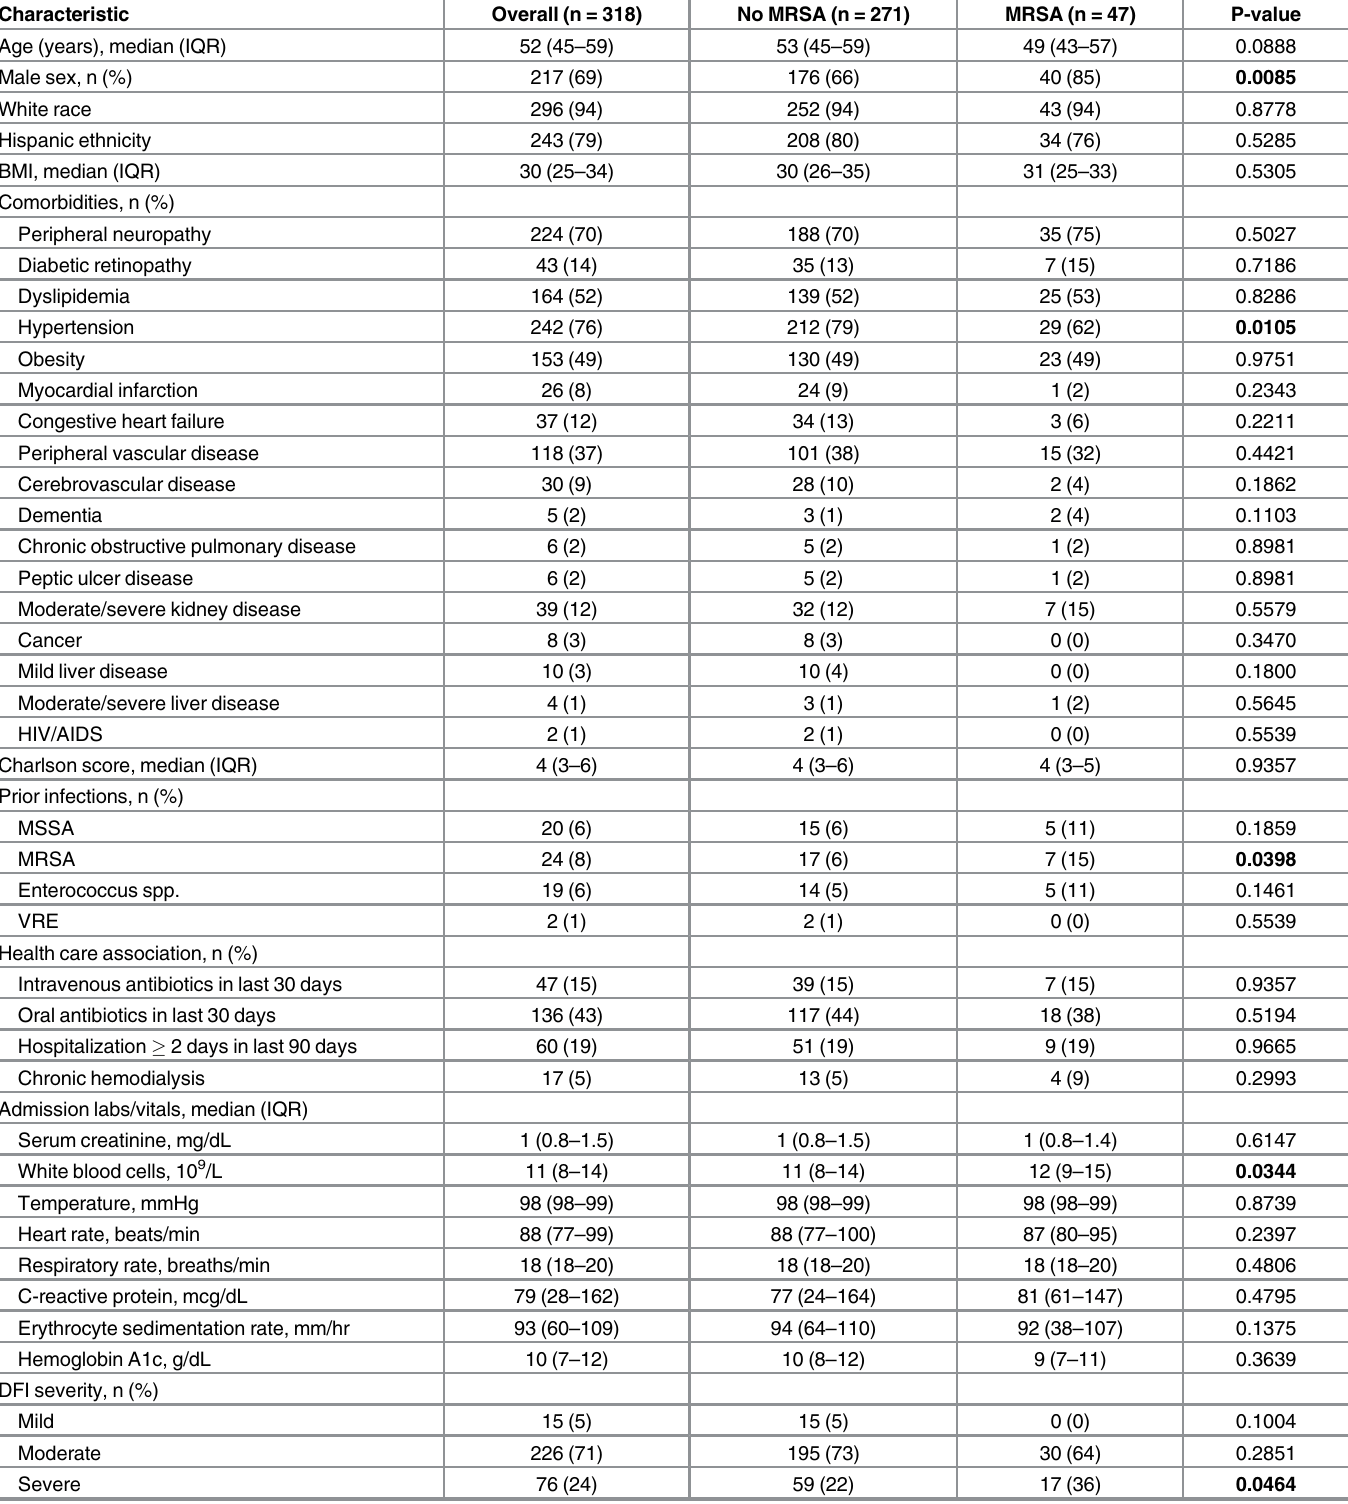
Table 2. Patient